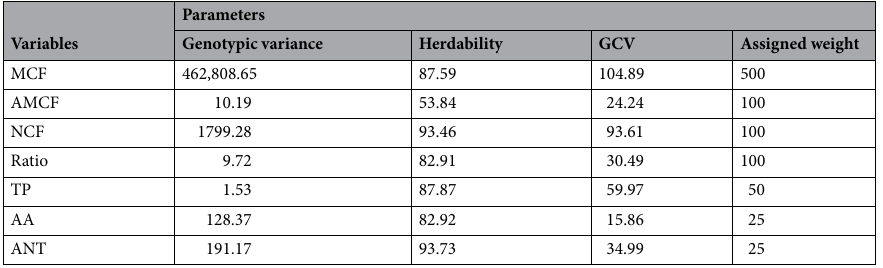
Table 6. Economic weights criteria used in the application of selection indices for trait analysis in 10 populations of Fragaria × ananassa Dutch. MCF mass of commercial fruits (g plant −1 ), AMCF average mass of commercial fruits (g fruit −1 ), NCF number of commercial fruits (fruits plant −1 ), Ratio, soluble solids